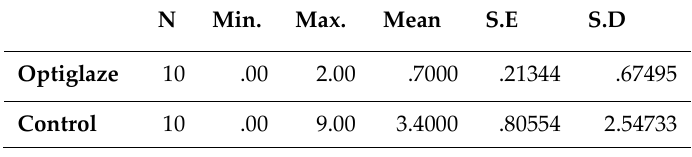
Table 1: Descriptive of porosity